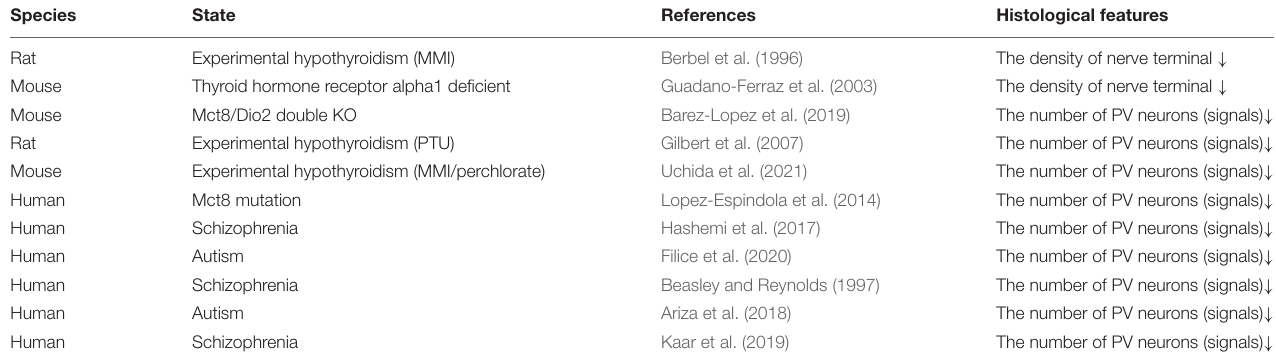
TABLE 2 | Morphological abnormalities of parvalbumin neurons in the